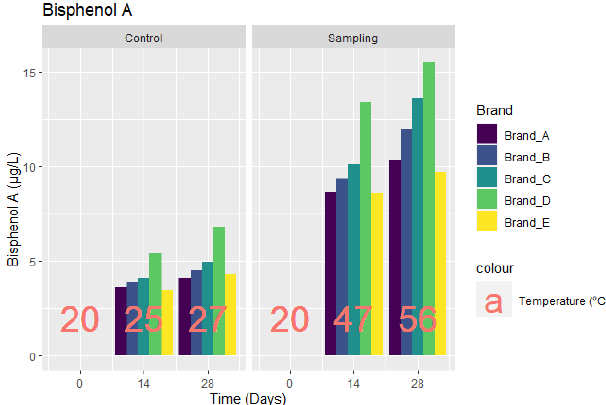
Figure 3. BPA values for the control group and sunlight exposure